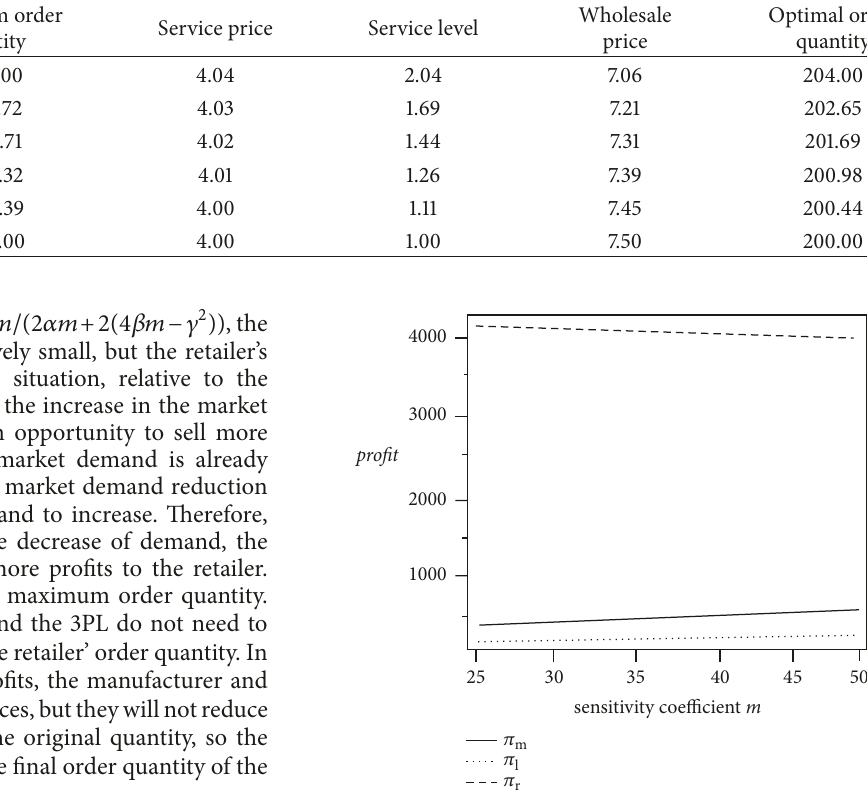
Table 1: The effect of the logistics investment cost on the supply chain members’ decisions.